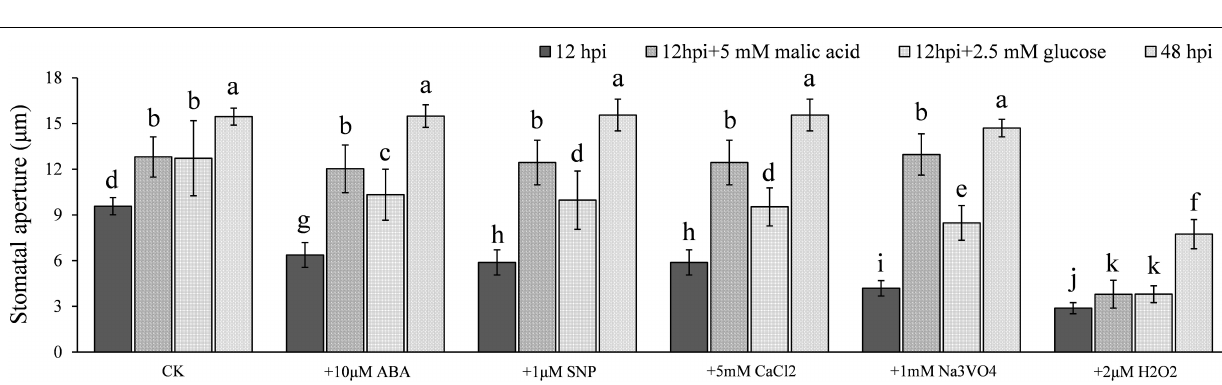
FIGURE 4 | P. infestans -induced stomatal opening correlates with starch degradation in guard cells: (A) starches in guard cells of P. infestans -infected potato leaves started to degrade at 12 hpi in dark, and at 24–48 hpi nearly no starch was visible in the guard cells; (B) images show starch in the guard cells of control (CK, no P. infestans inoculation) and infected (IF) potato leaves. Starches in the guard cells around the infection sites started to degrade 12 hpi. The marker = 10 µ m. Photos within a panel are from a representative of a single replicate while photos among panels are pooled from multiple replicates.